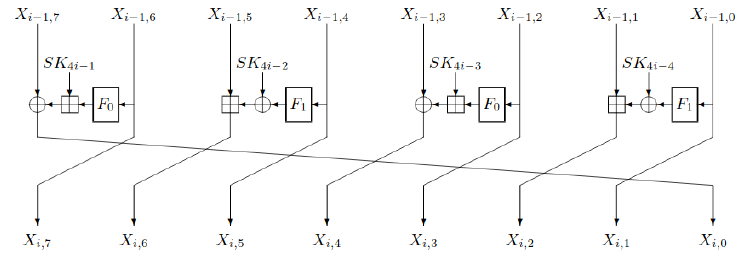
Figure 3: Round function of